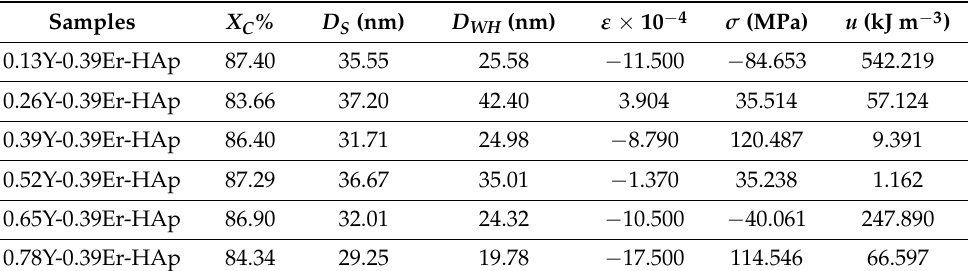
Table 3. The XRD-related calculated parameters.